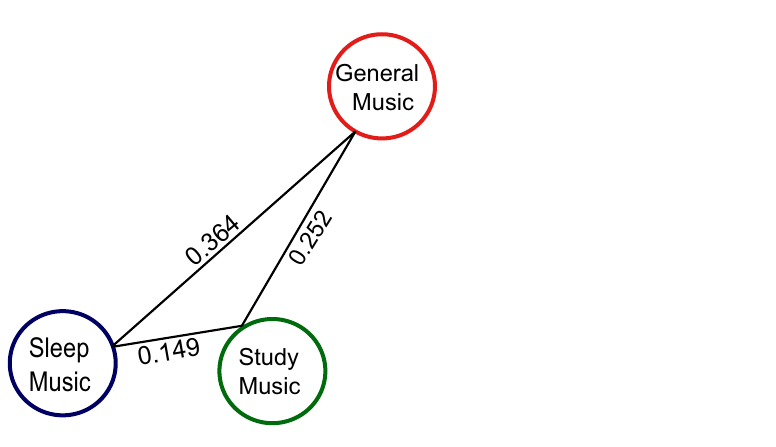
Figure 4. The Kolmogorov–Smirnov distance between General music and Sleep music, Sleep music and Study music and between General music and Study music across all nine audio features (Instrumentalness, Acousticness, Speechiness, Liveness, Tempo, Loudness, Energy, Valence and